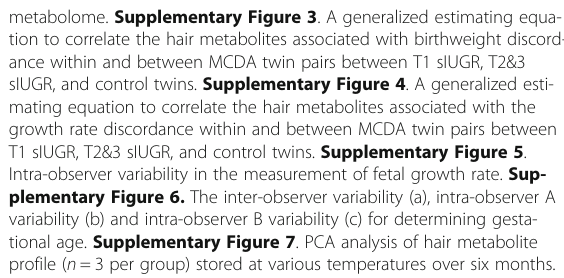
metabolome. Supplementary Figure 3 . A generalized estimating equa- tion to correlate the hair metabolites associated with birthweight discord- ance within and between MCDA twin pairs between T1 sIUGR, T2&3 sIUGR, and control twins. Supplementary Figure 4 . A generalized esti- mating equation to correlate the hair metabolites associated with the growth rate discordance within and between MCDA twin pairs between T1 sIUGR, T2&3 sIUGR, and control twins. Supplementary Figure 5 . Intra-observer variability in the measurement of fetal growth rate. Sup- plementary Figure 6. The inter-observer variability (a), intra-observer A variability (b) and intra-observer B variability (c) for determining gesta- tional age. Supplementary Figure 7 . PCA analysis of hair metabolite profile ( n = 3 per group) stored at various temperatures over six